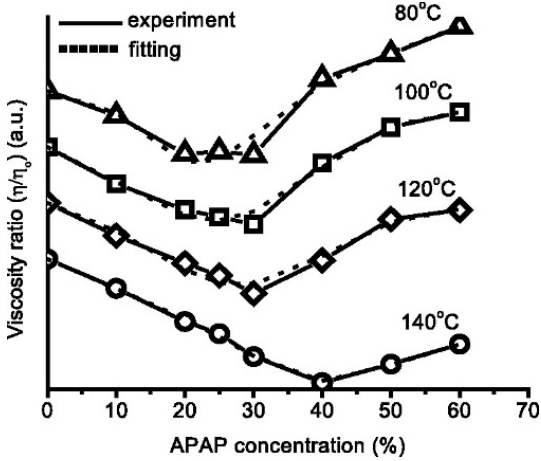
Figure 7. Viscosity ratio ( η / η o ) of acetaminophen (APAP) in poly (ethylene oxide) (PEO) at different temperatures to determine the solubility of the drug. Reprinted with permission from M Yang, International Journal of Pharmaceutics, Published by Elsevier, 2011 [123].